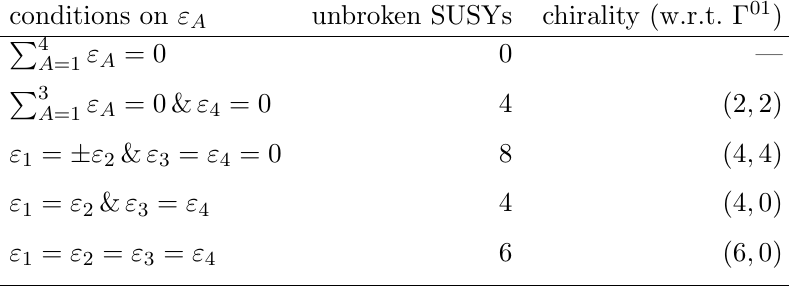
Table 2 . Unbroken supersymmetries in the D1 action for di(cid:11)erent choices of the " parameters. Killing spinors (unbroken supersymmetries). One last comment is needed about